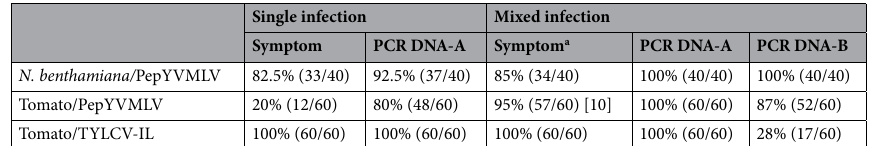
Table 1. Infectivity of PepYVMLV and TYLCV-IL DNA-As in single or mixed infection with PepYVMLV DNA-B after agroinoculation of N. benthamiana and tomato plants. a Square brackets: number of dead plants at the end of the experiment (32 dpi).